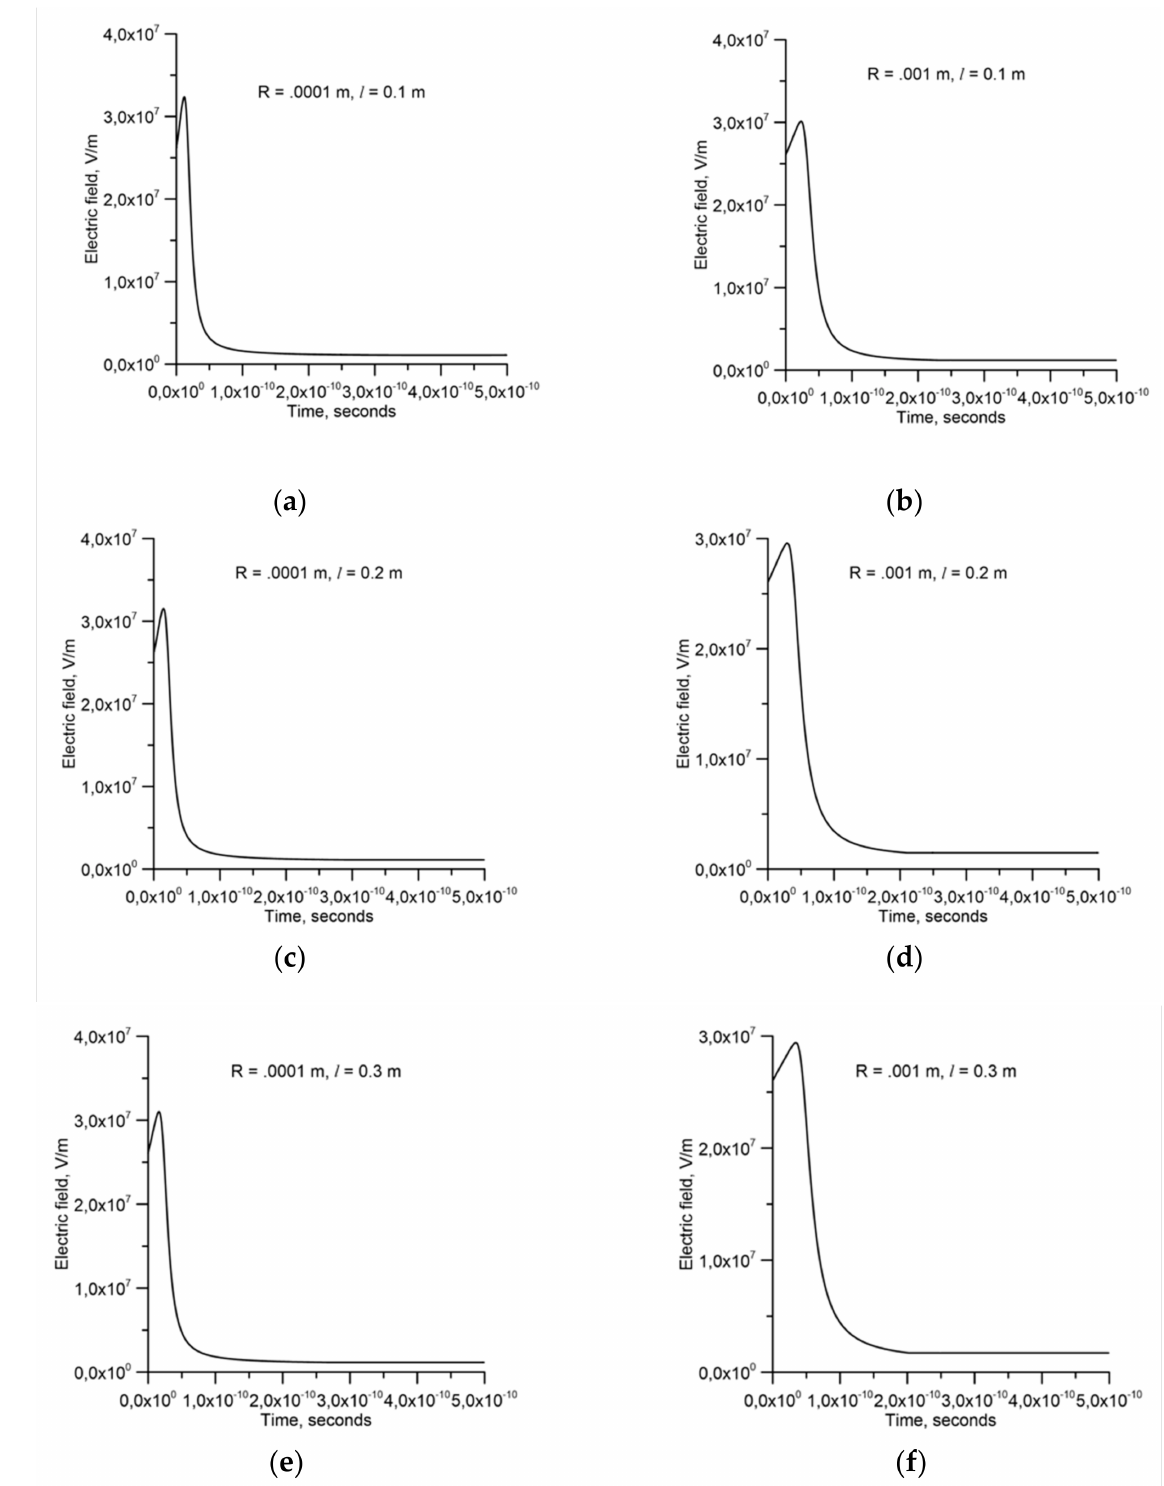
Figure 4. The electric field experienced by the accelerating electron as a function of time. In the calculations, it is assumed that the background electric field that polarizes the ionization wave is 10 6 V/m. The speed of propagation of the ionization wave is 10 7 m/s. Results are presented for different lengths of the ionization wave and the radius of the channel. ( a ) R = 0.0001 m, l = 0.1 m; ( b ) R = 0.001 m, l = 0.1 m; ( c ) R = 0.0001 m, l = 0.2 m; ( d ) R = 0.001 m, l = 0.2 m; ( e ) R = 0.0001 m, l = 0.3 m and ( f ) R = 0.001 m, l = 0.3